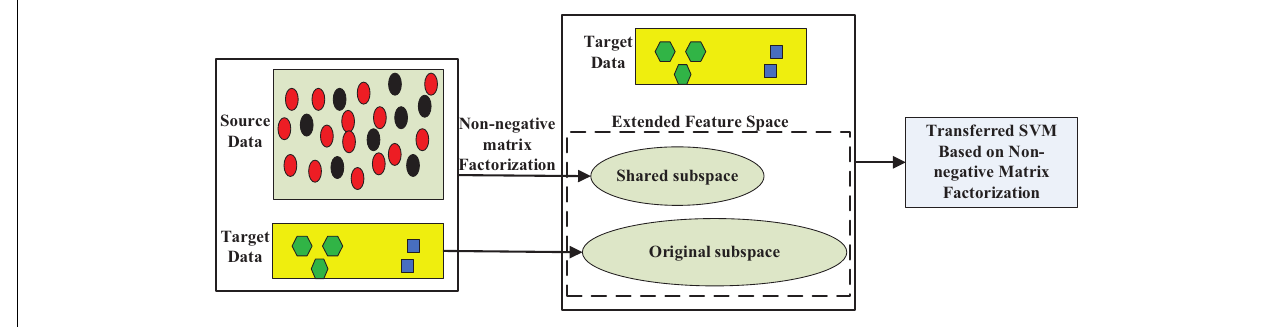
FIGURE 1 | Principle of the proposed transferred SVM based on non-negative matrix factorization.